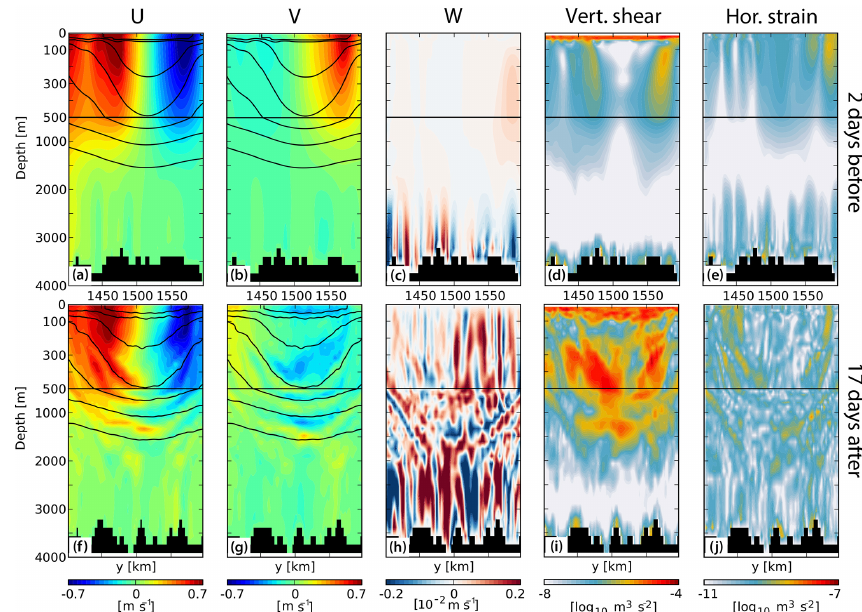
Figure 5. Model snapshots of a 2km simulation at a mesoscale eddy location 2 days before (top) and 17 days after (bottom) the passage of a storm: (a, f) zonal velocity (ms − 1 ) , (b, g) meridional velocity (ms − 1 ) , (c, h) vertical velocity (ms − 1 ) , (d, i) vertical shear (s − 2 ) and (e, j) horizontal strain (s − 2 ) . Snapshots after the passage of the storm (e–h) are taken 50km eastward in order to account for the advection of the core of an anticyclonic mesoscale eddy. Isotherm are shown in the left panels ( (a) , (b) , (f) and (g) ) with contour intervals of 1.25 ◦ C from 2.5 to 10 ◦ C. Before the passage of the storm the simulation has been equilibrated without high-frequency forcing, so the solution at day 2 is free of wind-forced NIWs. The snapshots shown here correspond to day 2 and 22 in the time axis of Fig. 8. We choose day 22 to leave enough time for the NIWs to reach the base of the anticyclonic eddy.